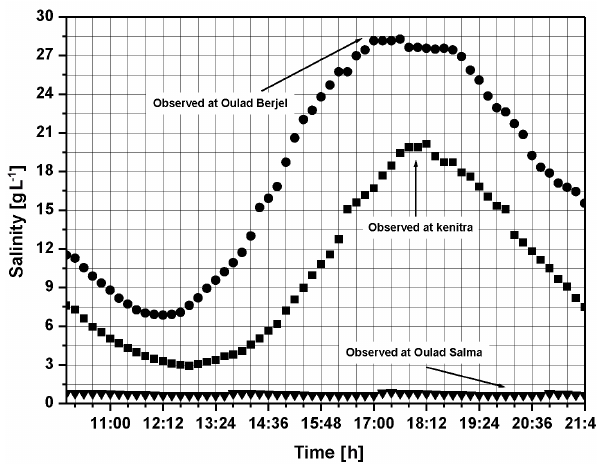
Figure 7. Salinity evolution in the Sebou river estuary during spring tide (surveyed on 11 February